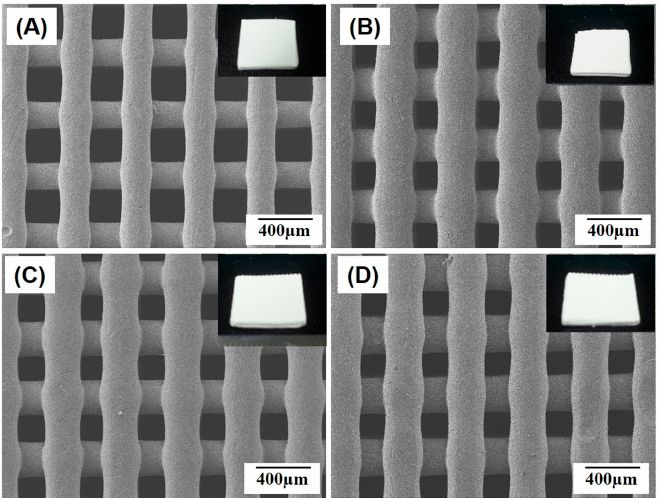
Figure 2. Representative field emission scanning electron microscopy (FE-SEM) images of the macro/micro-porous PCL/HA composite scaffolds produced with various HA contents of ( A ) 0 wt %; ( B ) 10 wt %; ( C ) 15 wt %; and ( D ) 20 wt %, showing the construction of straight PCL/HA struts and macrochannels. Insets in Figure 2A–D show representative optical images of the porous scaffolds.